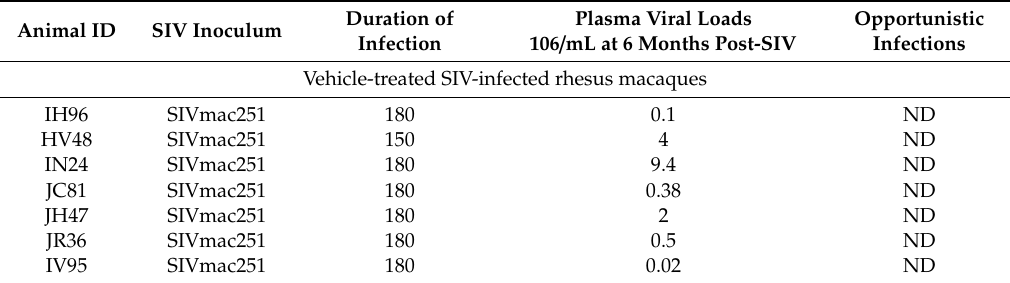
Table 1. Animal IDs, SIV inoculum, duration of infection and plasma viral loads in vehicle-